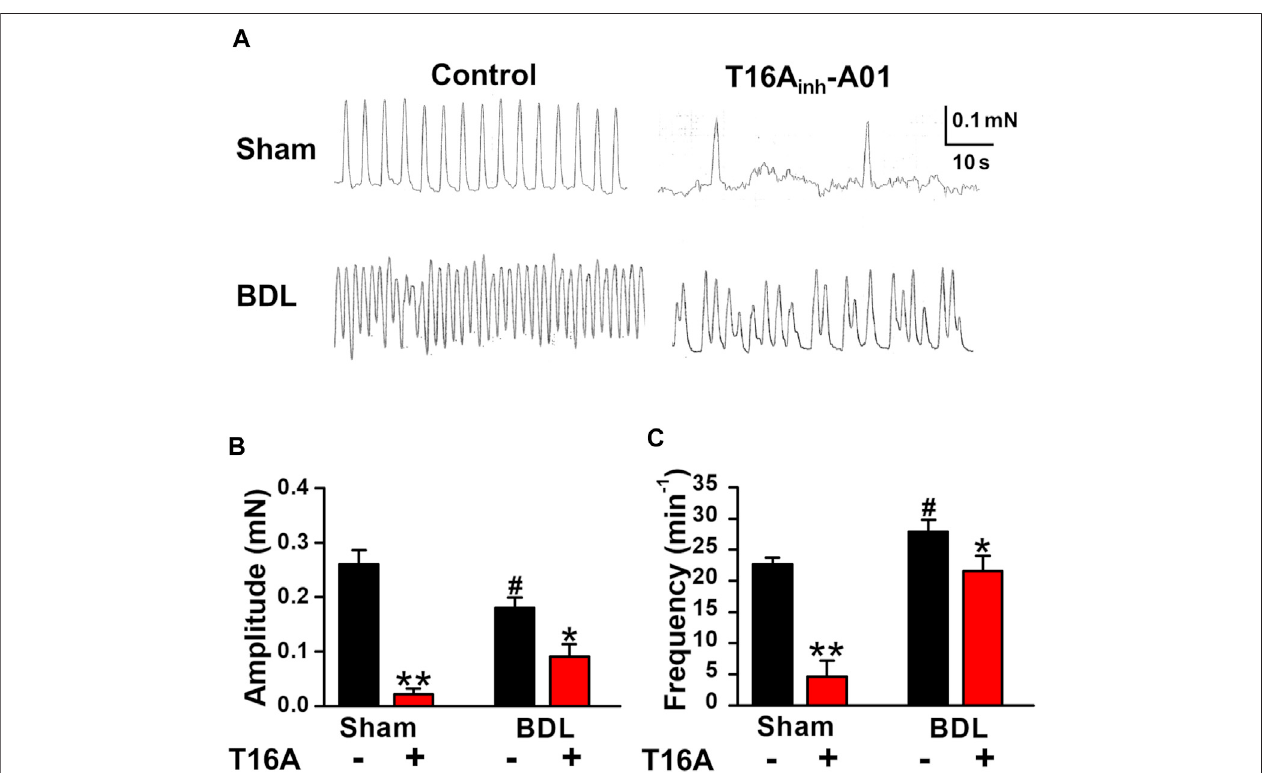
FIGURE 4 | Attenuated spontaneous contraction in PVSMs from BDL mice. The characteristics of spontaneous contraction and effects of T16A inh -A01, a speci fi c inhibitor of TMEM16A channels, on spontaneous contraction in PVSMs were analyzed in BDL mice. (A) Representative recordings of spontaneous contraction in the absence and presence of 30 μ M T16A inh -A01 in sham- and BDL-PVSMs. (B) The amplitude of spontaneous contractions in the absence and presence of T16A inh -A01 (T16A)insham-andBDL-PVSMs( n =5 – 8). (C) ThefrequencyofspontaneouscontractionsintheabsenceandpresenceofT16A inh -A01(T16A)insham-andBDL- PVSMs ( n = 5 – 8). Data are presented as means ± S.E. * p < 0.05, ** p < 0.01 versus control; # p < 0.05 versus